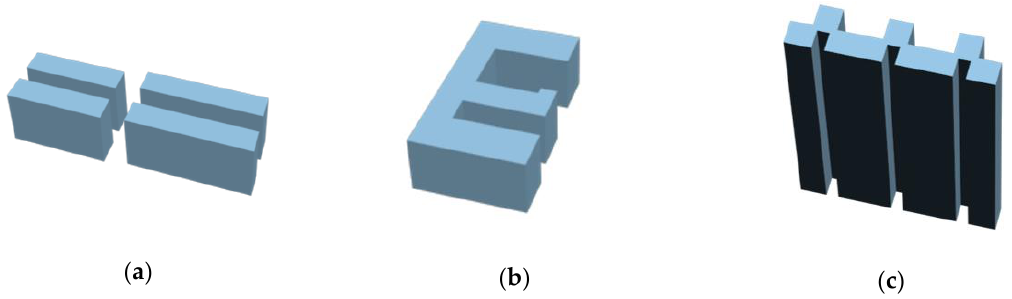
Figure 1. Wall types of ordinary urban buildings (in 3D): ( a ) flat walls, ( b ) walls with uneven parts on one side, and ( c ) walls with uneven parts on both sides.